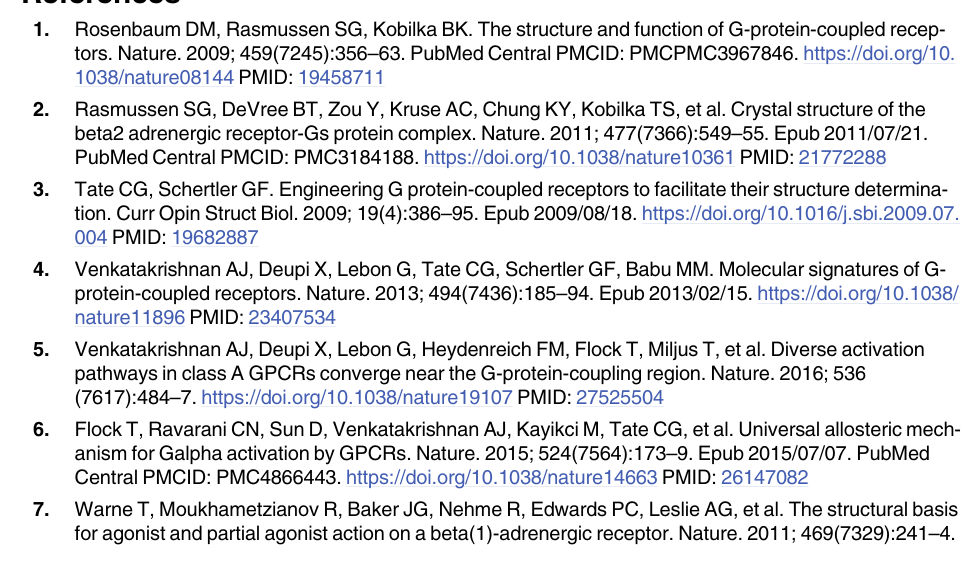
R–mini-G complex. (a) The 1B o1